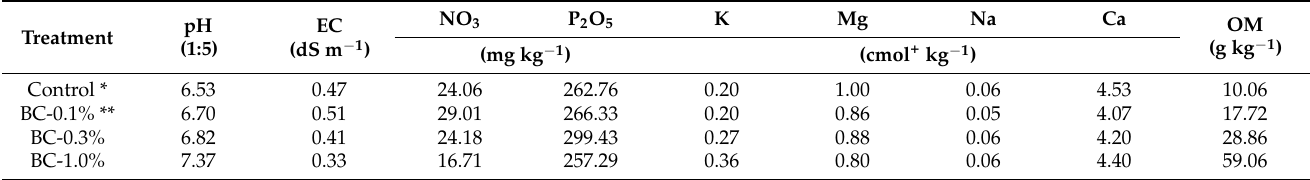
Table 1. Physicochemical properties of field soil used in the experiment.